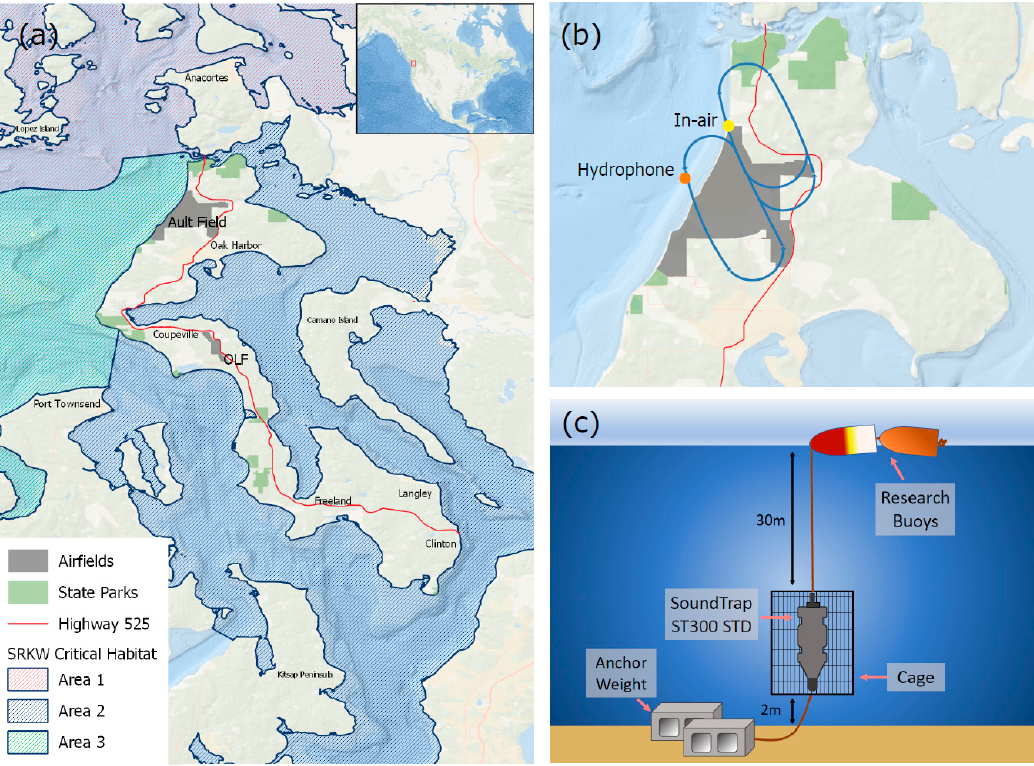
Figure 1. Map of the study area, location of underwater and in-air sound recordings, and schematic of hydrophone mooring. ( a ) Whidbey Island and surrounding areas, showing the location of Naval Air Station Whidbey Island’s two airfields (Ault Field and OLF), largest cities and towns, and state parks. Critical habitat areas (Areas 1–3) for Endangered Southern Resident killer whales are shown. ( b ) Location of SoundTrap (orange circle) and in-air recordings (yellow circle) relative to Ault Field and field carrier landing practice (FCLP) flight tracks 32 and 14 (blue lines). Flight tracks were georeferenced from the Environmental Impact Statement [17]; two other flight tracks around Ault Field (tracks 7 and 25, oriented east-west) are not shown. ( c ) Schematic of the SoundTrap mooring, which was deployed from 15 August–11 September 2019. The SoundTrap was housed in a coated wire cage attached to a concrete block anchor with a 2 m line; a 30 m line attached to buoys kept the SoundTrap suspended above the sea